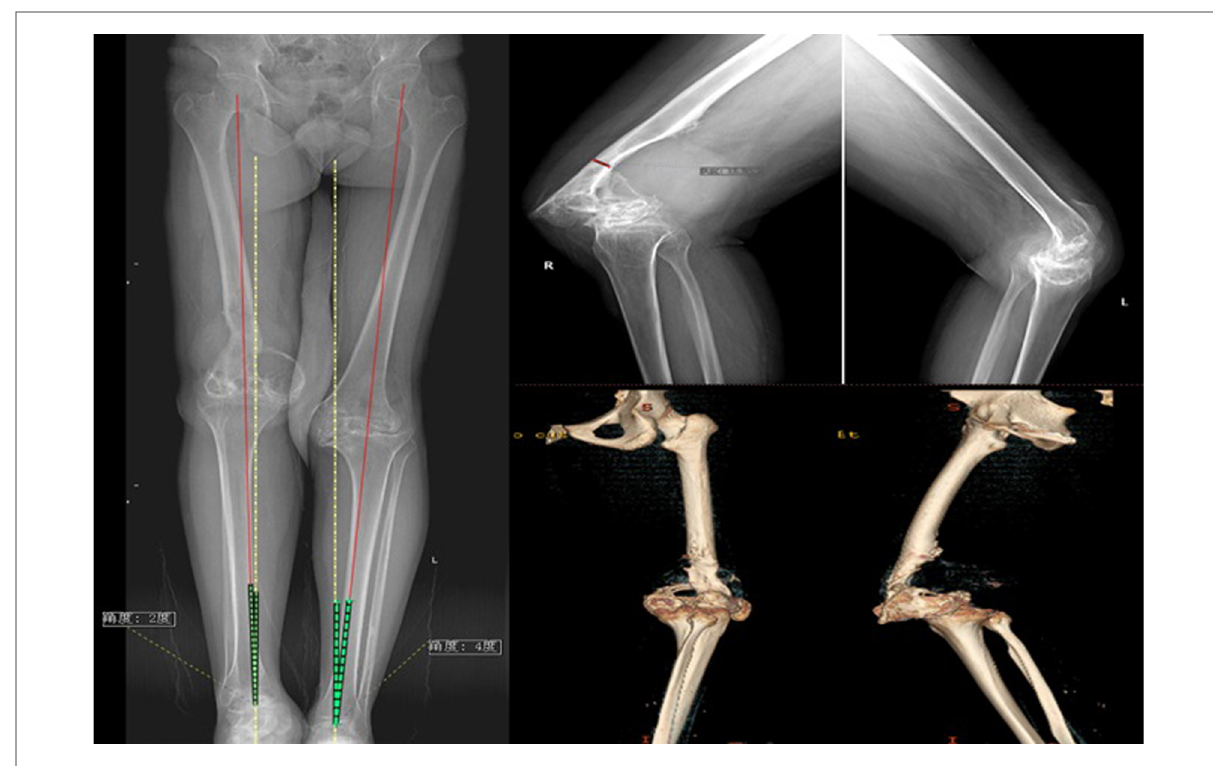
FIGURE 1 Preoperative roentgenograms and CT reconstruction of hemophilic arthropathy of the